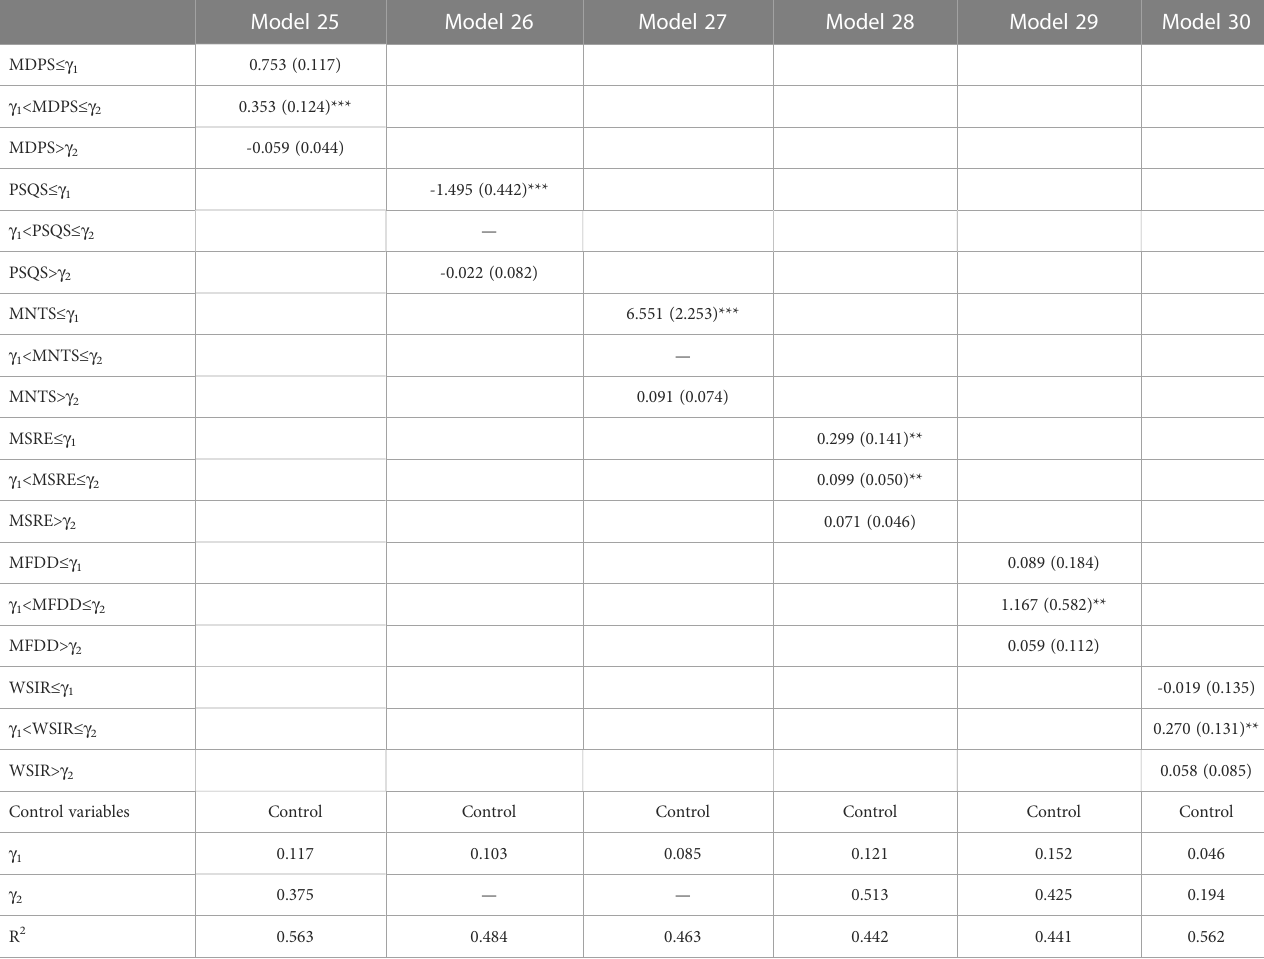
TABLE 5 The threshold model results of GECG in the major grain producing